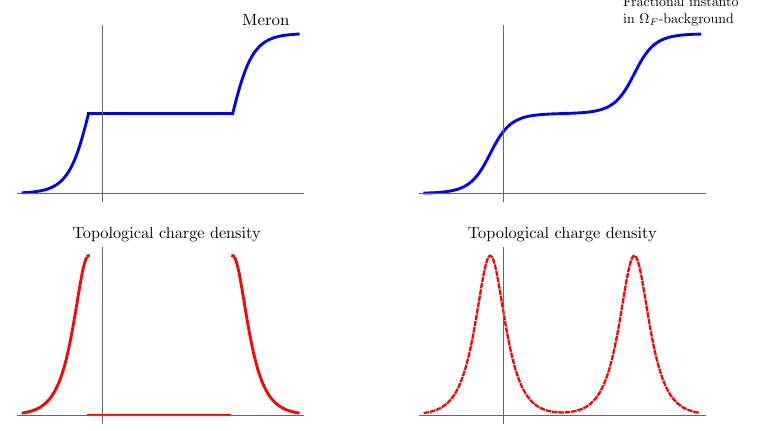
Figure 8 . Horizontal axis is the angular coordinate on S 1 continuous or discontinuous. Action is asserted to be log divergent [25], but that needs a re- interpretation, see text. b) Instanton solution in the Ω is a critical point at infinity. Above configuration is on the Lefschetz thimble of this exact critical point. Insertion of B (2) ’t Hooft flux, one can isolate each smooth configuration with topological charge 1 2